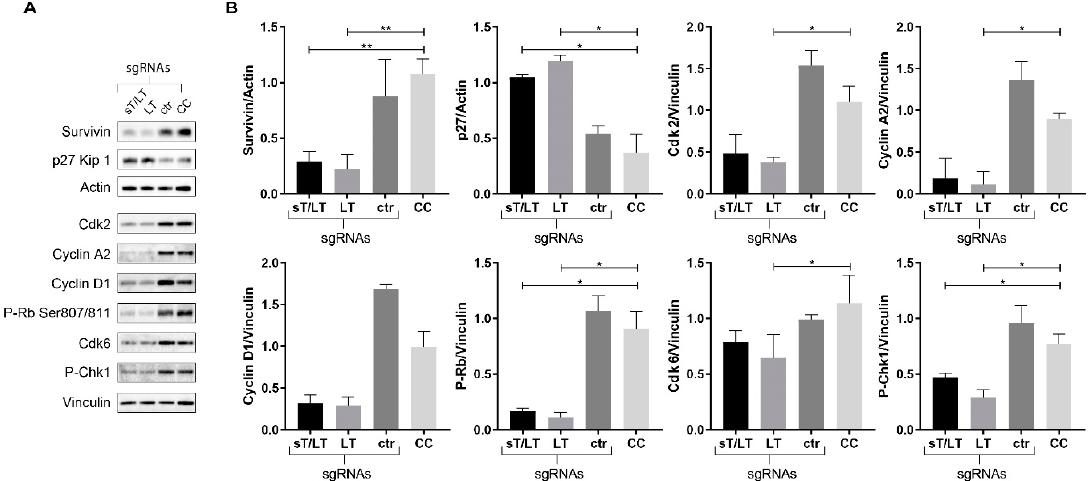
Figure 6. Altered cell cycle regulation upon CRISPR / Cas9 editing of MCPyV TAs. ( A ) Blots, representative of three independent experiments, of total protein extracts from WAGA cells expressing the indicated constructs and non-transfected cells (CC) as controls. Actin and Vinculin were used as internal loading controls; ( B ) Densitometry analysis of blots normalized with actin or vinculin. Data represent mean values ± SD fromthree independent blots. Statistical significance compared with cell control (CC) is indicated.